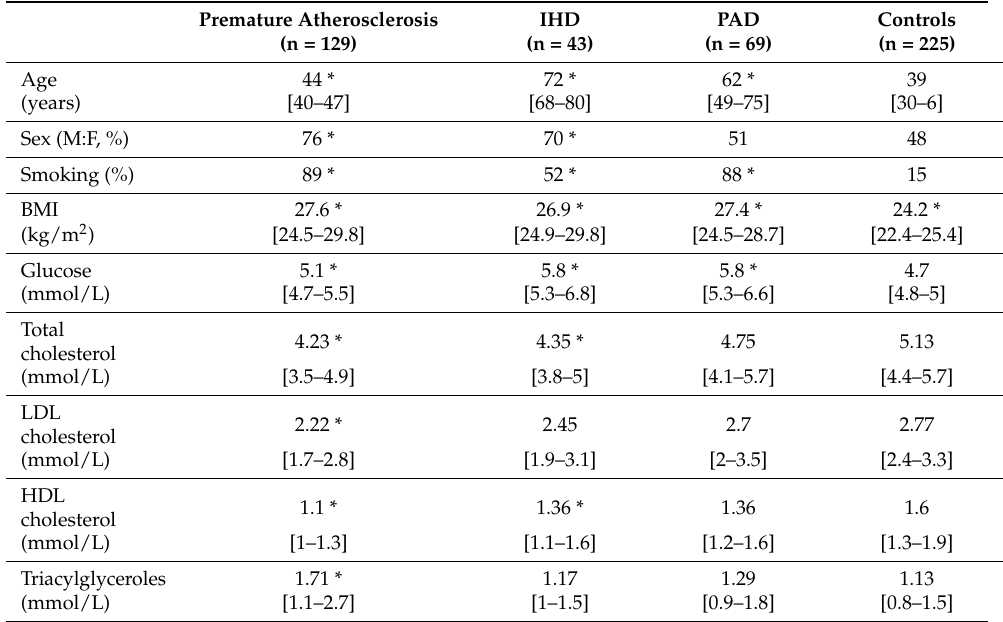
Data expressed as median [25–75%]; ANOVA on Ranks with Dunn’s post hoc analyses were used for all pairwise comparisons. * p < 0.05. IHD, ischemic heart disease; PAD, peripheral artery disease; TAS, total antioxidant status; ND, not done. Table 8. Metabolic parameters and other factors that affect the development of